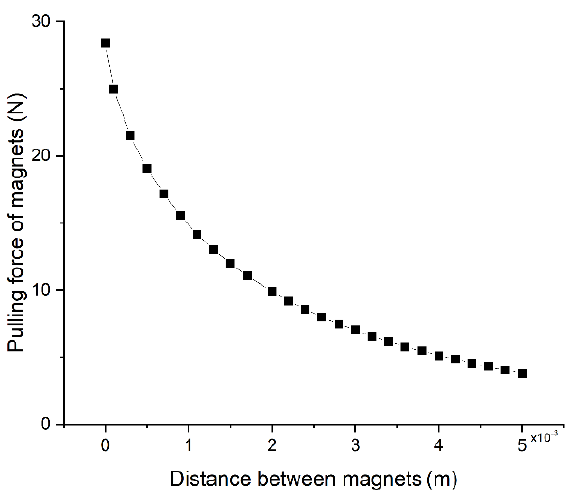
Figure 10. Pulling force of magnet according to distance.